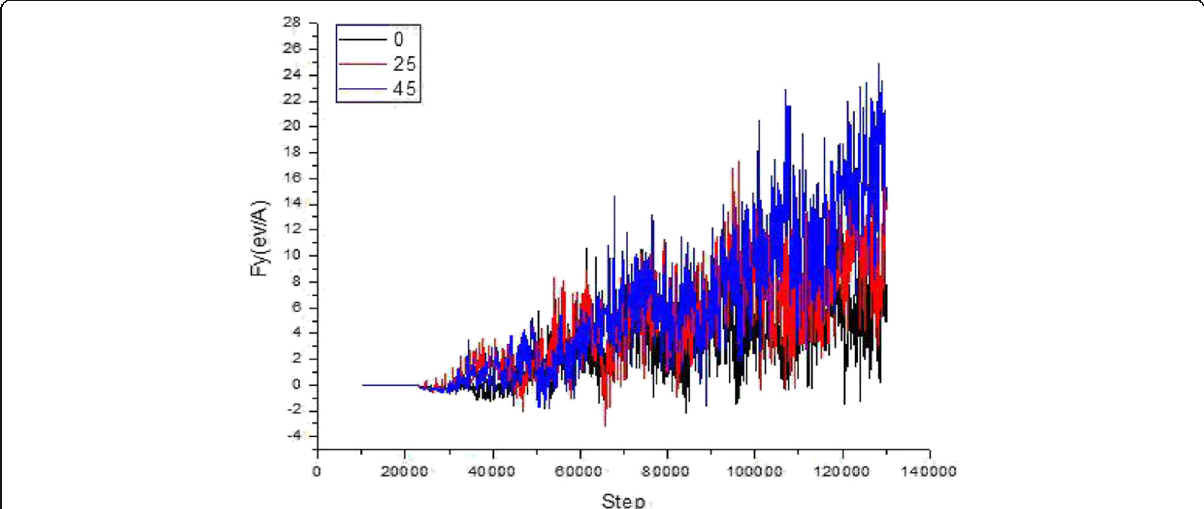
Fig. 4 The relationship between the cutting force, the cutting angle, and the simulation step